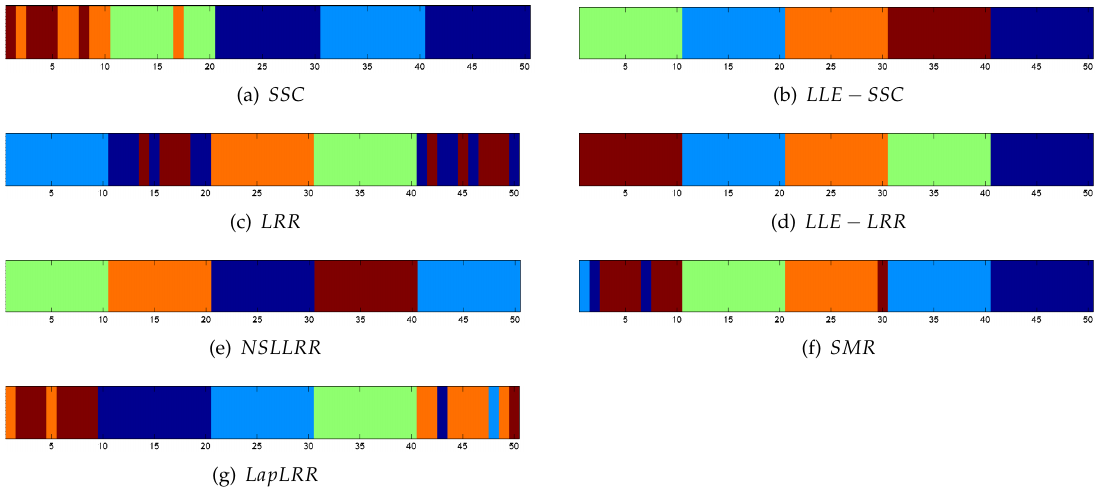
Figure 2. The clustering results of the clustering methods of ( a ) SSC; ( b ) LLE-SSC; ( c ) LRR; ( d ) LLE-LRR; ( e ) NSLLRR; ( f ) SMR and ( g ) LapLRR on the synthetic dataset with 20% Gaussian